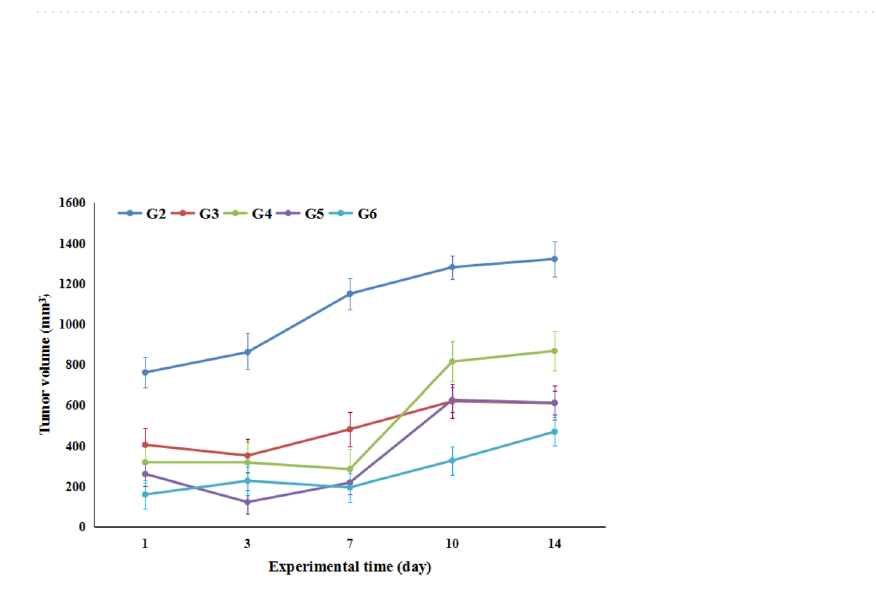
Figure 5. The tumor volume of tumor bearing experimental groups. Data is displayed as mean ± standard error. G2: tumor control group, G3: doxorubicin-treated group, G4–G6: groups treated with 5, 10 & 20% PSO nano- emulsion,